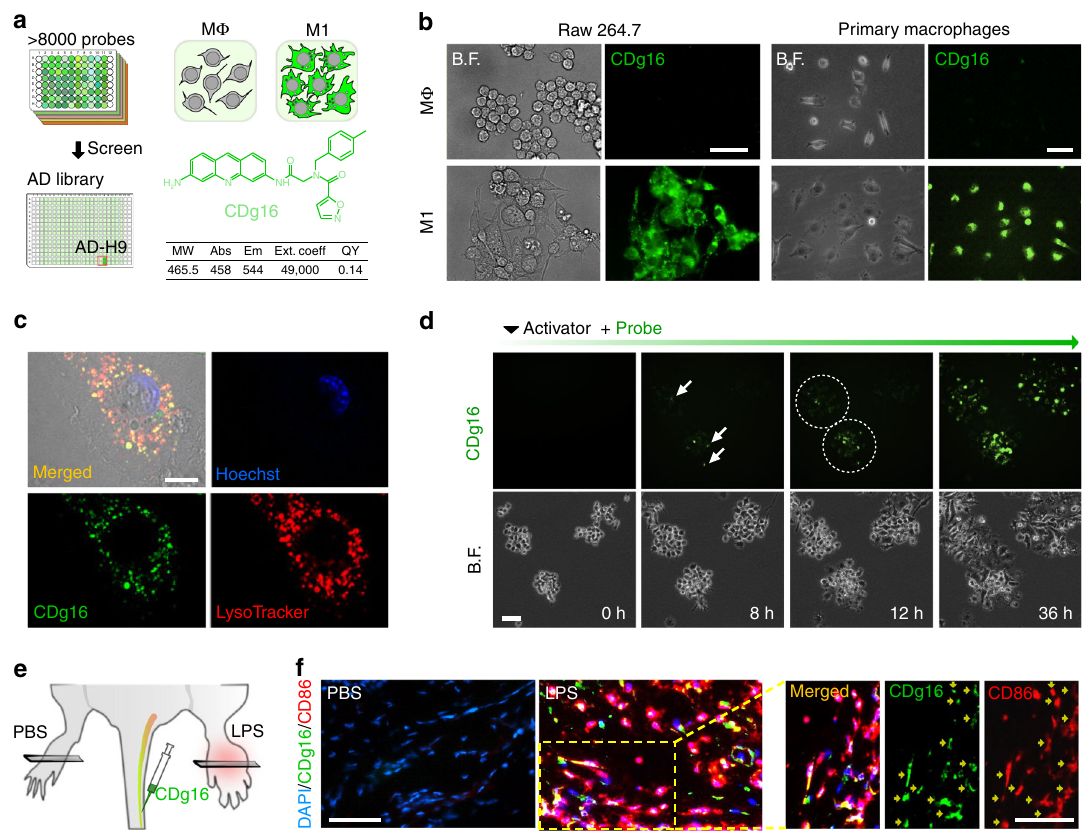
Fig. 1 CDg16-stained activated macrophages. a The screening process and structure of the selected fl uorescent probe, CDg16. Table shows the molecular/ fl uorescence properties of CDg16. b M φ (non-activated macrophages) and lipopolysaccharide (LPS) and interferon-gamma (IFN ɣ ) activated M1 (classically activated macrophages) were used to examine the selectivity of CDg16. CDg16 stained only LPS and IFN ɣ treated Raw264.7 cells. LPS and IFN ɣ activated peritoneal macrophages (primary macrophages) were also stained by CDg16. c CDg16 signals colocalized with LysoTracker, which stains lysosomes. d With time tracking, CDg16 signals were found to appear 8 h after LPS and IFN ɣ treatment. Arrows indicate stained cells and dotted circles show the tracking of the CDg16-stained area. e Schematic of CDg16 application for the LPS-injected acute in fl ammation paw model with CDg16 tail vein injection. f CDg16 showed strong staining in the LPS-injected paw (LPS panel) and CDg16-positive cells colocalized with an activated macrophage marker (CD86 IHC, yellow arrows). The merged image was magni fi ed from the inset yellow dotted square. Scale bars, 50 µ m ( b , c , e , f ) and 10 µ m ( d ). Data are representative of at least three independent experiments unless indicated